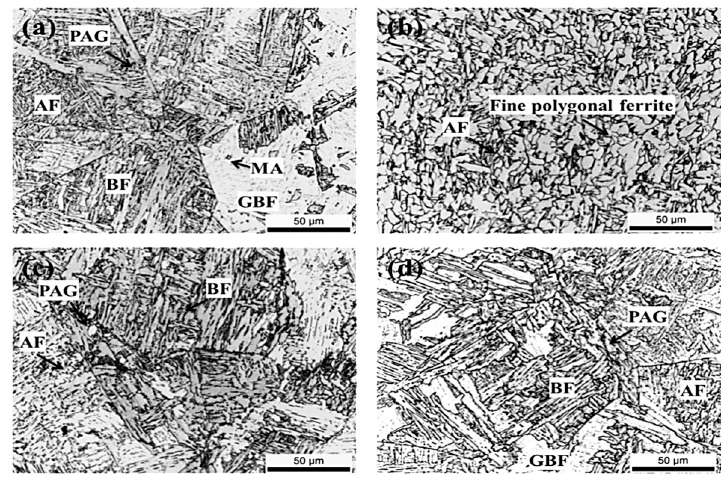
Figure 4. LOM microstructure of each simulated HAZ: ( a ) CGHAZ; ( b ) FGHAZ; ( c ) IRCGHAZ; and ( d ) SRCGHAZ [25].